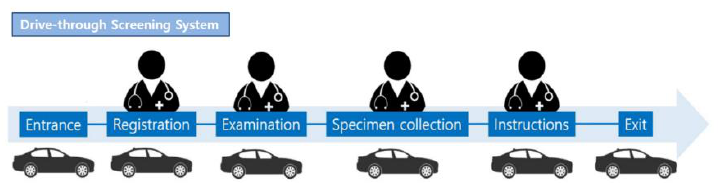
Figure 2. Illustration of the drive-through SARS-CoV-2 screening process.